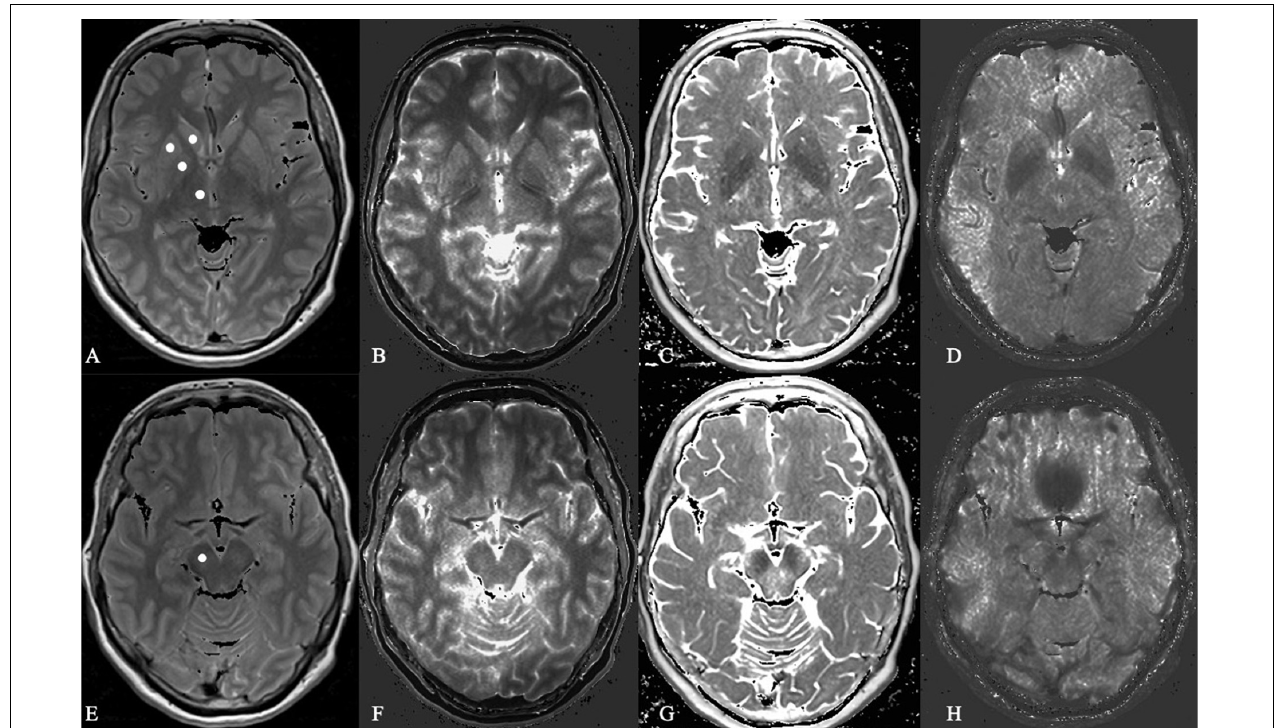
FIGURE 2 | Microstructural analysis of proton density, T1 relaxation time, T2 and T2 prime in a Parkinson’s disease patient. In this Figure shows the basal ganglia (A–D) and mesencephalon (E–H) in proton density-weighted (A,E) , T1-weighted (B,F) , T2-weighted (C,G) , and T2 prime-weighted (D,H) MR sequences obtained from a 62-year-old female PD